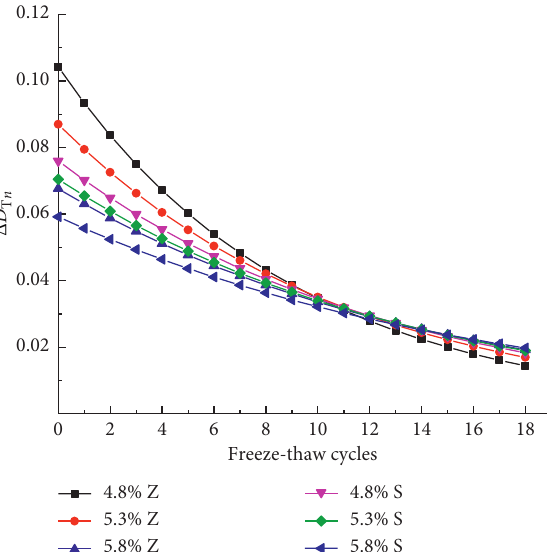
Figure 6: Evolution curves of split freeze-thaw damage.